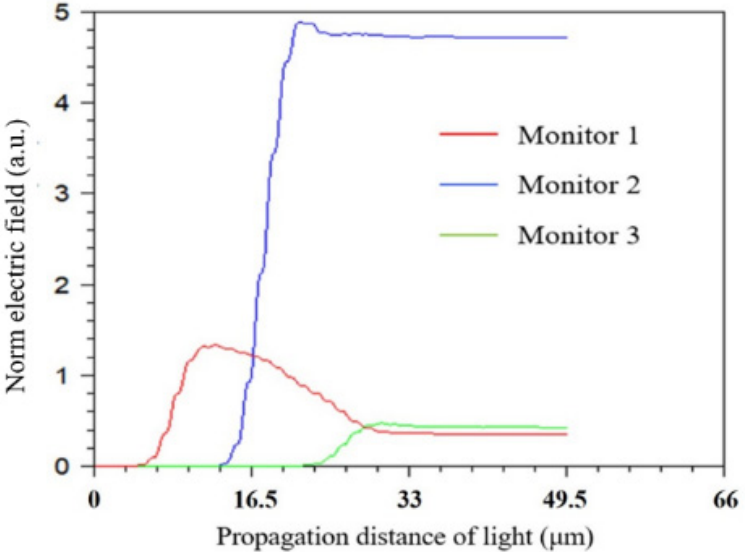
Figure 5. ( a ) The electric field distribution of incident light propagating through the SW in DSCF whose silicon core diameter was 1.5 µm. ( b ) The electric field of the cross section of the slot region .